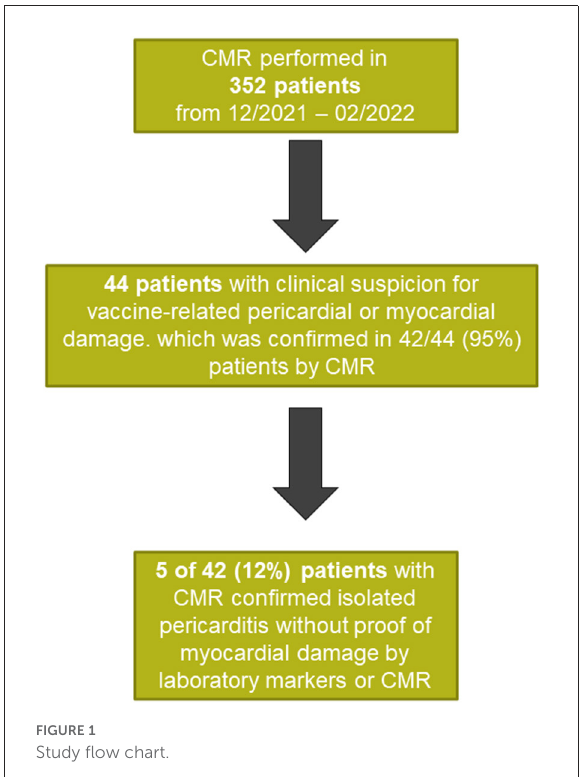
FIGURE1 Study flow